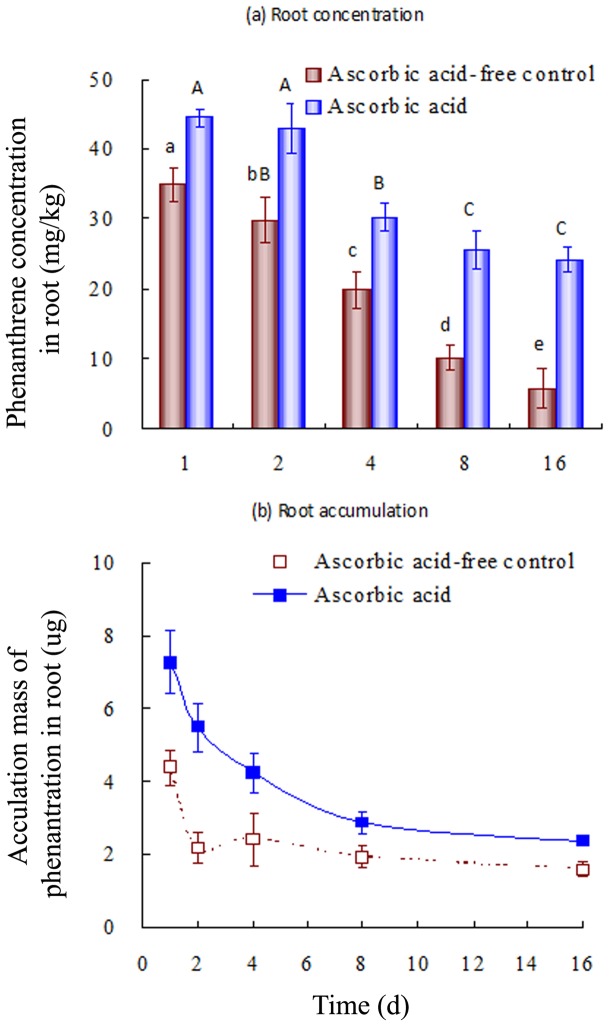
(a) Phenanthrene concentration and (b) accumulation in the roots of tall fescue as a function of uptake time.The initial phenanthene concentration was 1.0 mg/L. Error bars represent standard deviations (SD). Values above columns followed by the same letter are not significantly different (p>0.05).